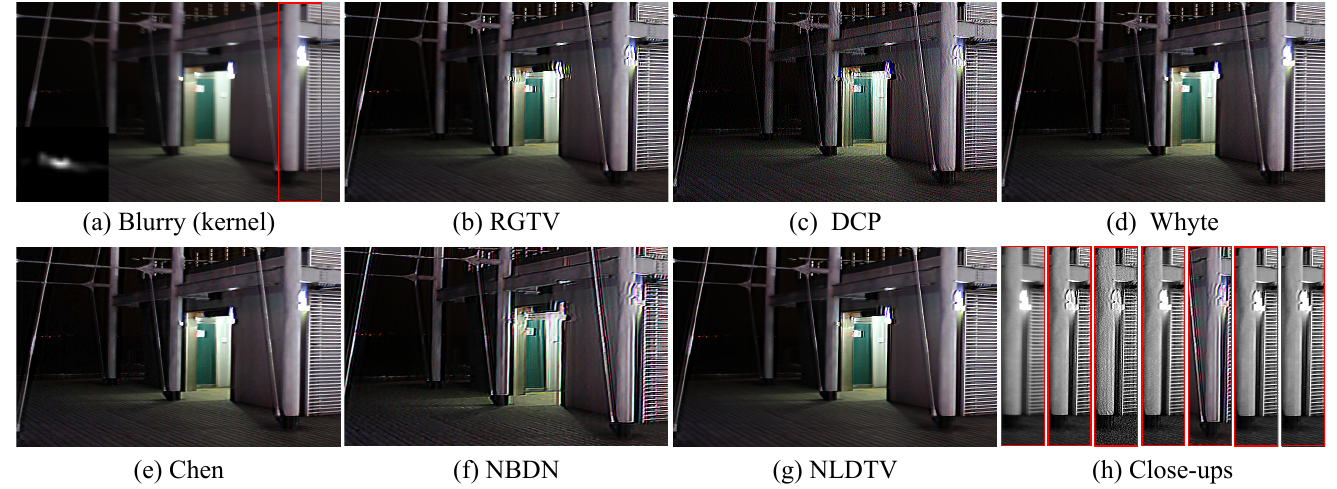
Figure 9. Results of deblurring a real-world saturated image. ( a ) Blurry image and estimated blur kernel and ( b – g ) restored by RGTV [28], DCP [5], Whyte [14], Chen [19], NBDN [35], and the proposed NLDTV. ( h )